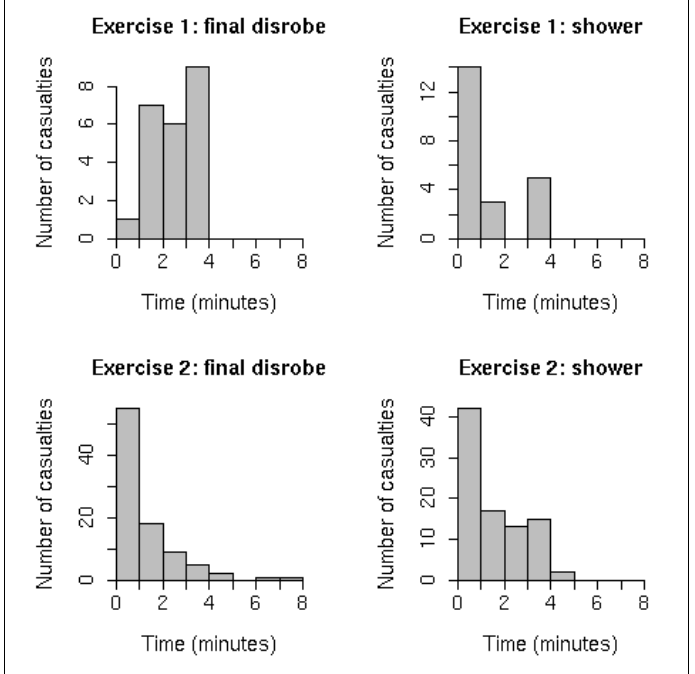
Figure 2. Histograms of the final disrobe and shower durations for both exercises.